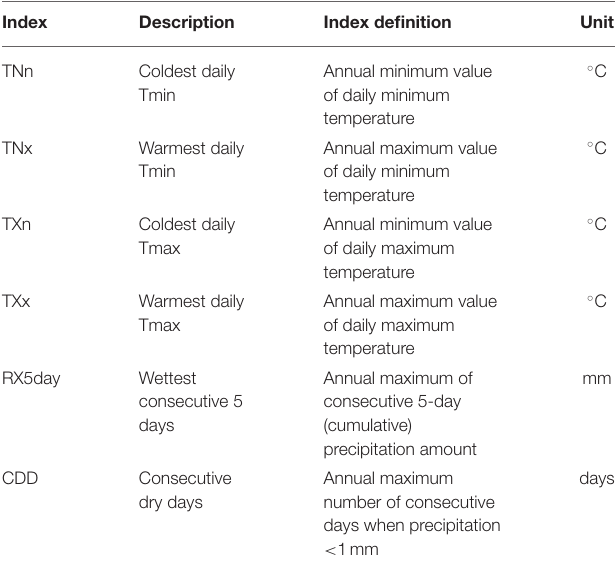
TABLE 1 | Subset of the temperature and precipitation extreme indices from ETCCDI used in this